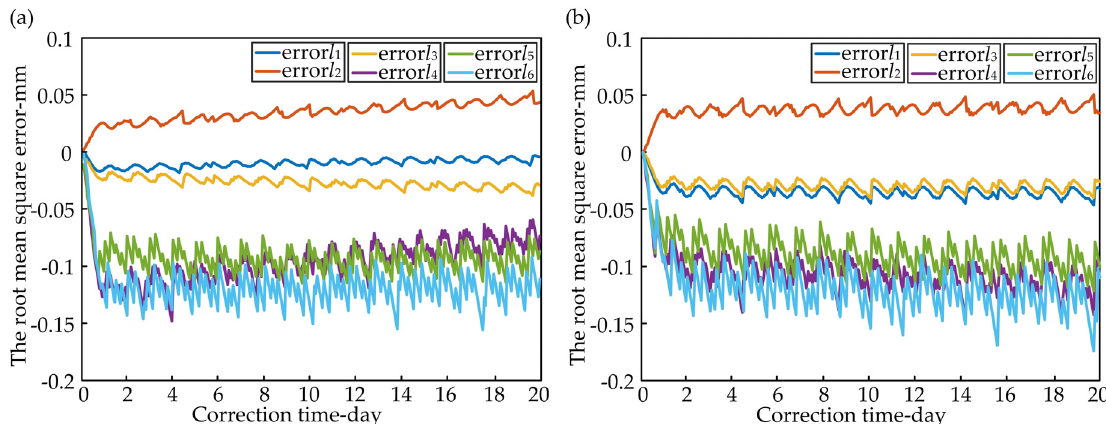
Figure 12. The deviations between the actual values and the theoretical value of the length of the rods. ( a ) The deviation with the strategy of equal joint adjustment. ( b ) The deviation with the strategy of joint adjustment for equal bone distraction.